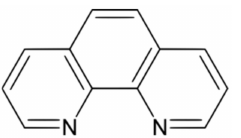
Figure 1. Molecular structure of 1,10-phenanthroline